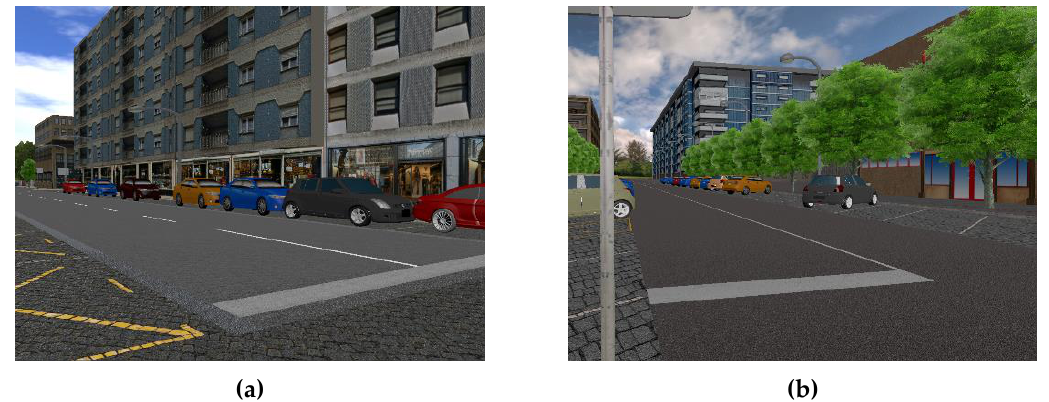
Figure 1. The two virtual scenarios: Rua 25 de Abril (a); and Rua Teixeira de Pascoais (b) .